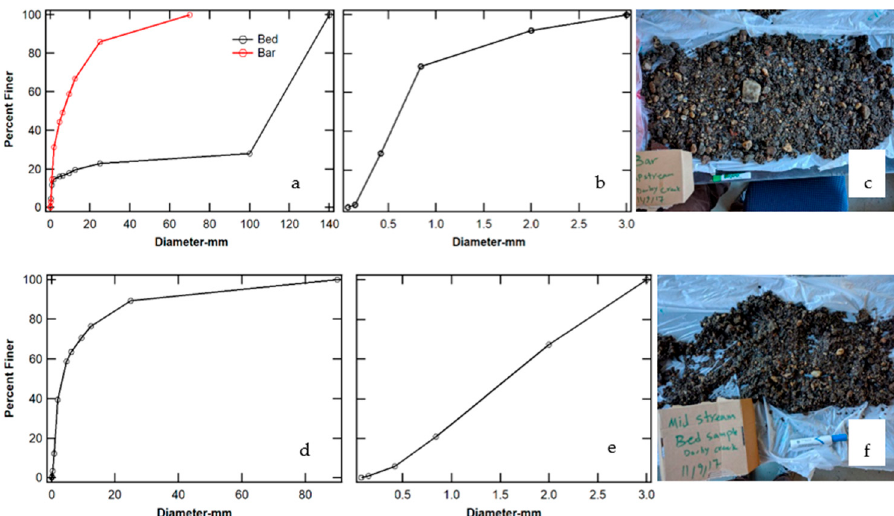
Figure 3. The upper graphs and pictures depict the grain size for ( a ) the bed, and the bar, ( b ) the substrate (below gravel armoring) and ( c ) a picture of the bar sample from the upper part of the domain (rkm 2 located at 39.925192, − 75.245647). The lower grouping depicts the grain size for ( d ) the bed, ( e ) the substrate, and ( f ) a picture of the bed sample from the lower part of the domain (rkm 4 located at 39.907534, − 75.250224).